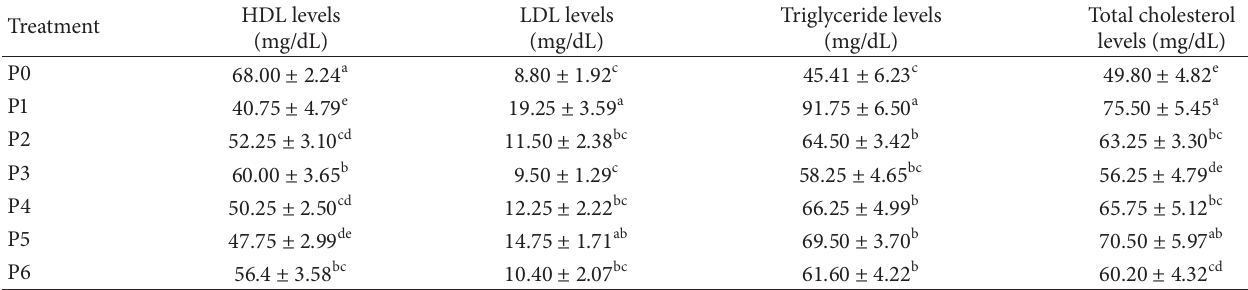
Table 4: Lipid profile of diabetic rats treated with or without various salacca